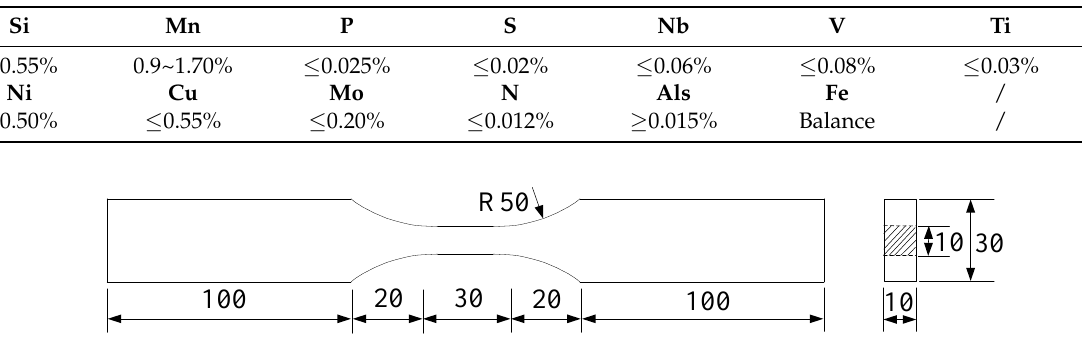
Table 1. Chemical compositions of grade Q345q steel (wt%).